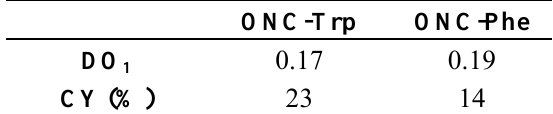
and CY (%) for ONC-Trp and ONC-Phe obtained by conductometric Table 2. DO 1